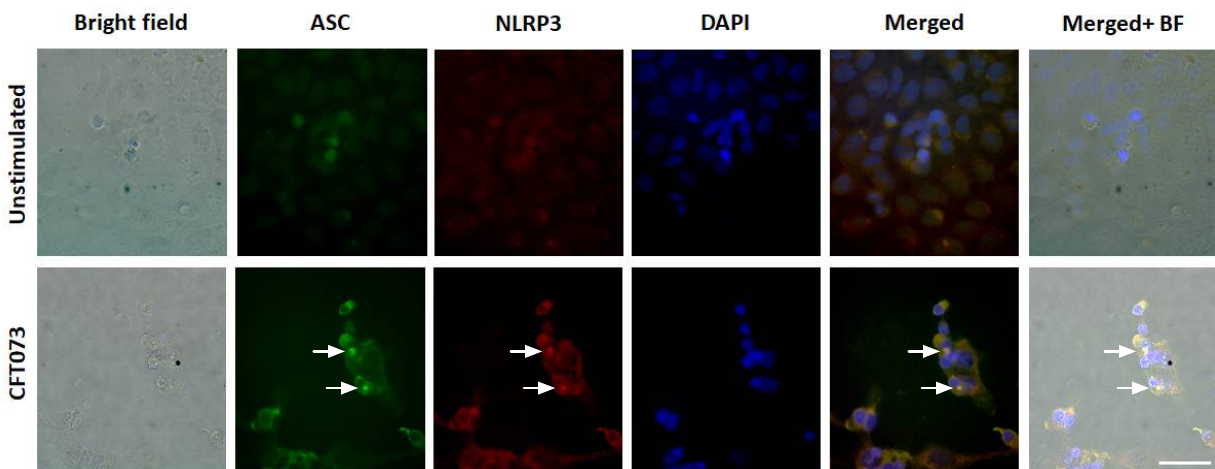
Figure 3. ASC-speck formation during a UPEC infection. Renal fibroblasts were infected with UPEC strain CFT073 at MOI 1 for 4 and ASC-speck formation and NLRP3 localization were visualized with fluorescence microscopy. Green represents ASC, red represents NLRP3 and blue (DAPI) represents the nucleus. Scale bar represents 50 µm. Arrows show colocalized specks. Images are representative of 3 independent experiments.